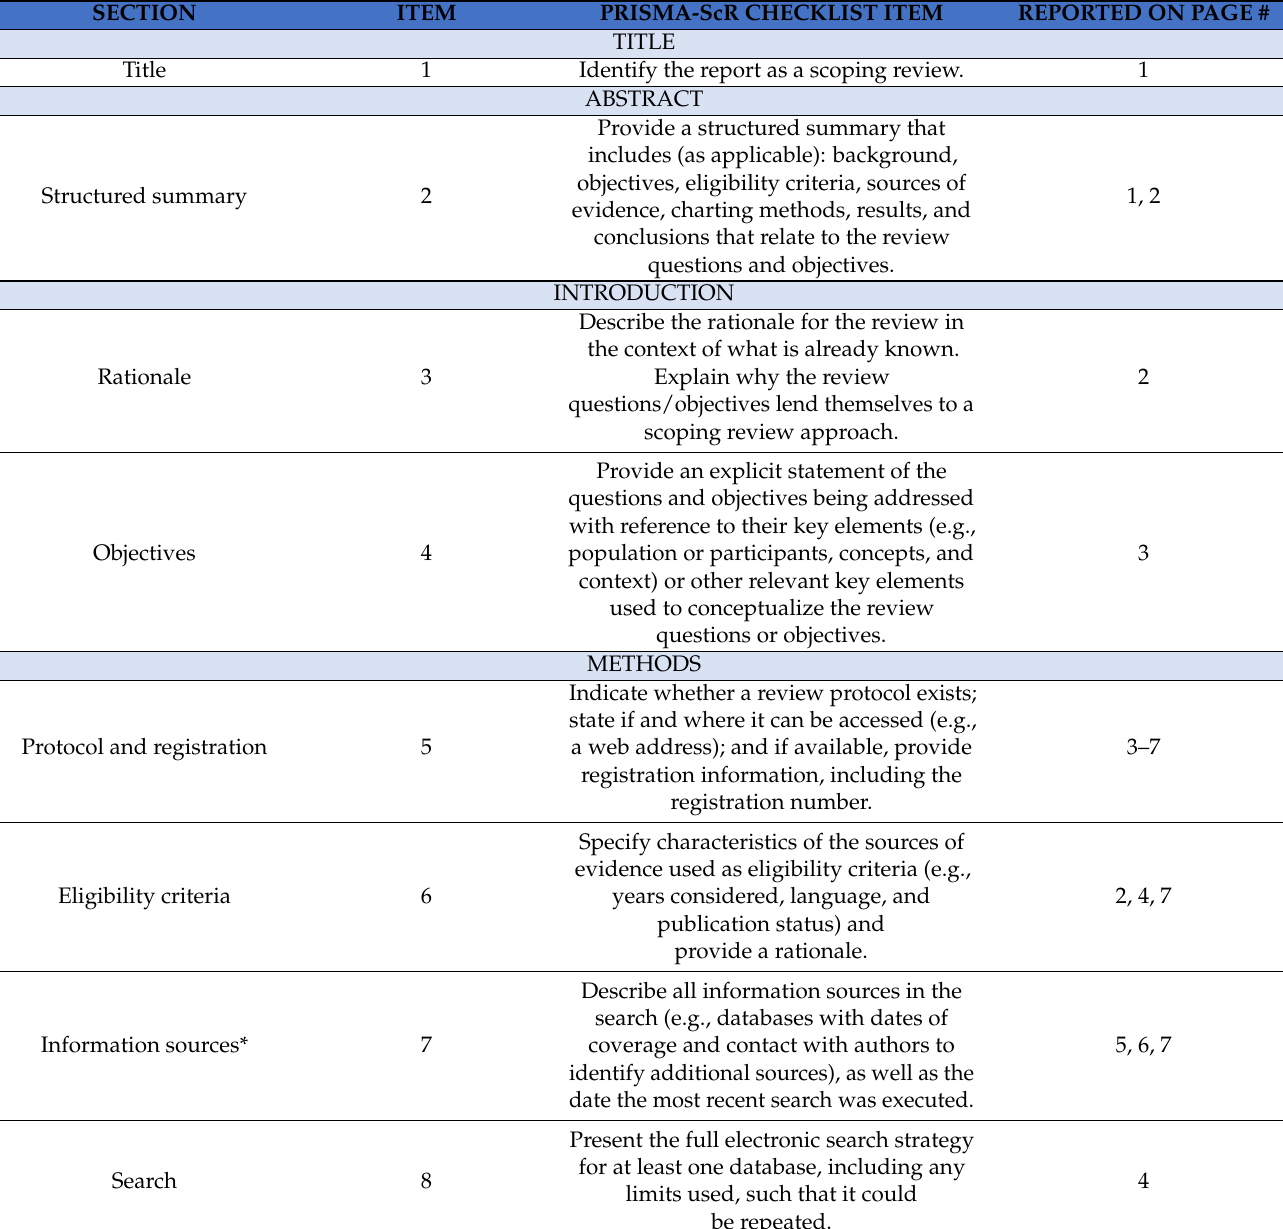
Table A1. Preferred Reporting Items for Systematic reviews and Meta-Analyses extension for Scoping Reviews (PRISMA- ScR)